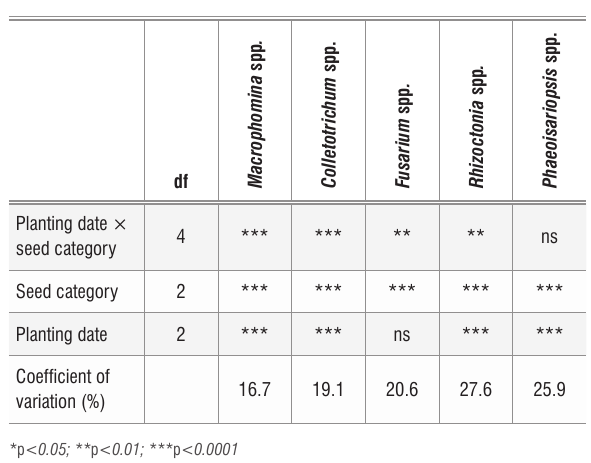
Analysis of variance for the effects of planting date and seed category on seed-borne fungi